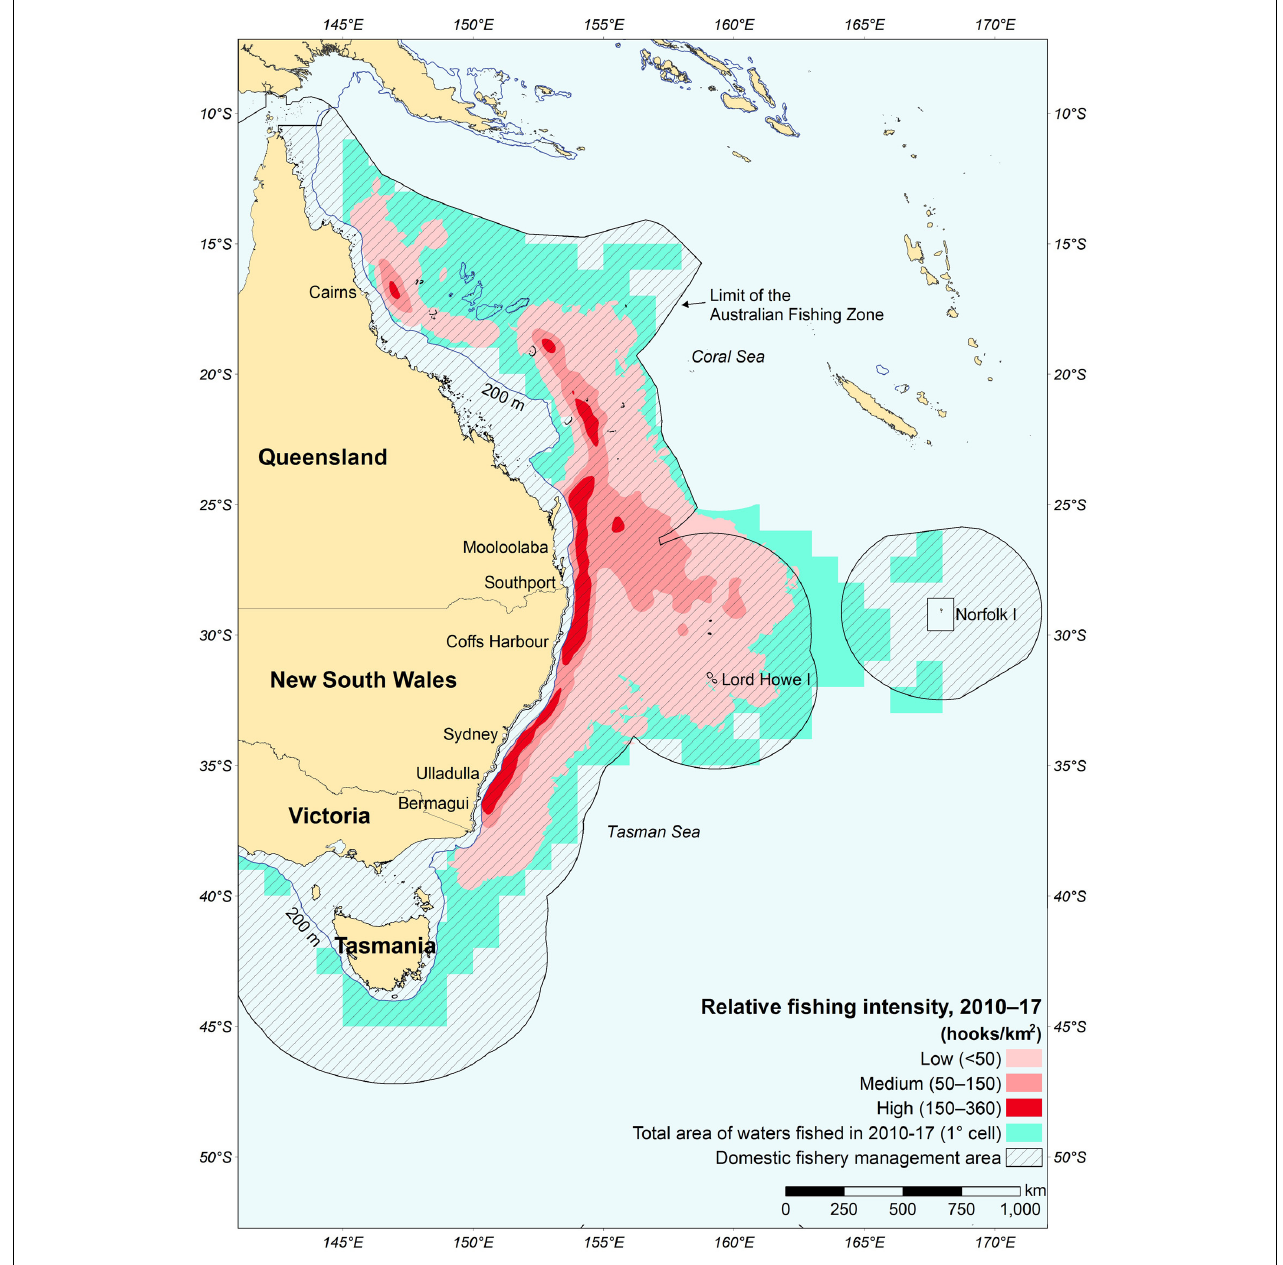
FIGURE 1 | Area and relative fishing intensity in the Eastern Tuna and Billfish Fishery (ETBF) between 2010 and 2017 calendar